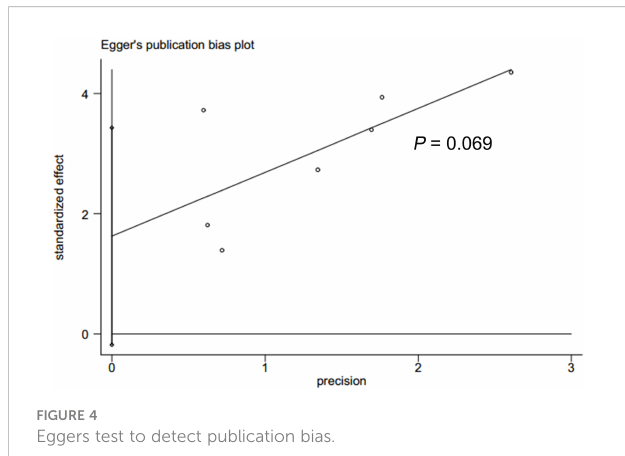
FIGURE 4 Eggers test to detect publication